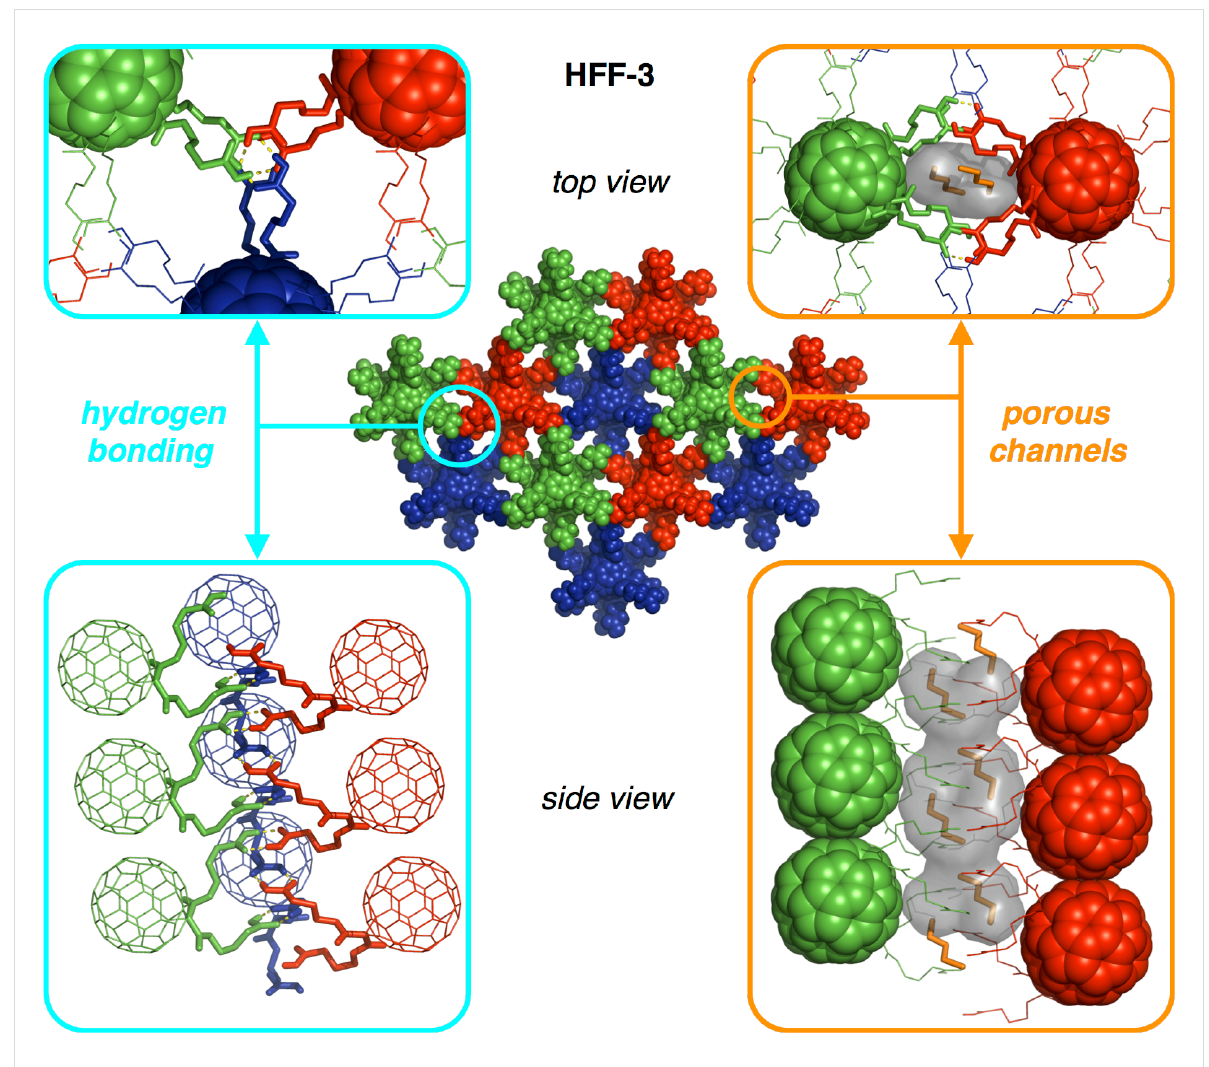
Figure 4: Hydrogen bonding network for HFF-3 (left, hydrogen bonds yellow) and porous channels along the c axis filled with unbound Et 2 O mole- cules (right, Et 2 O orange, inner pore surface indicated in grey); images are created with PyMOL